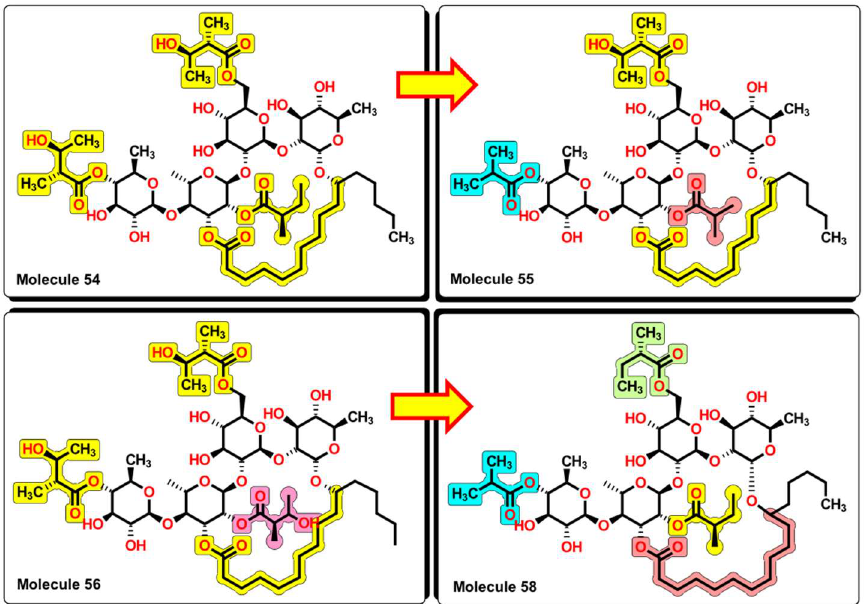
Figure 16. SAR analysis of compounds 54 , 55 , 56 , and 58 . Small changes in the structure expand the